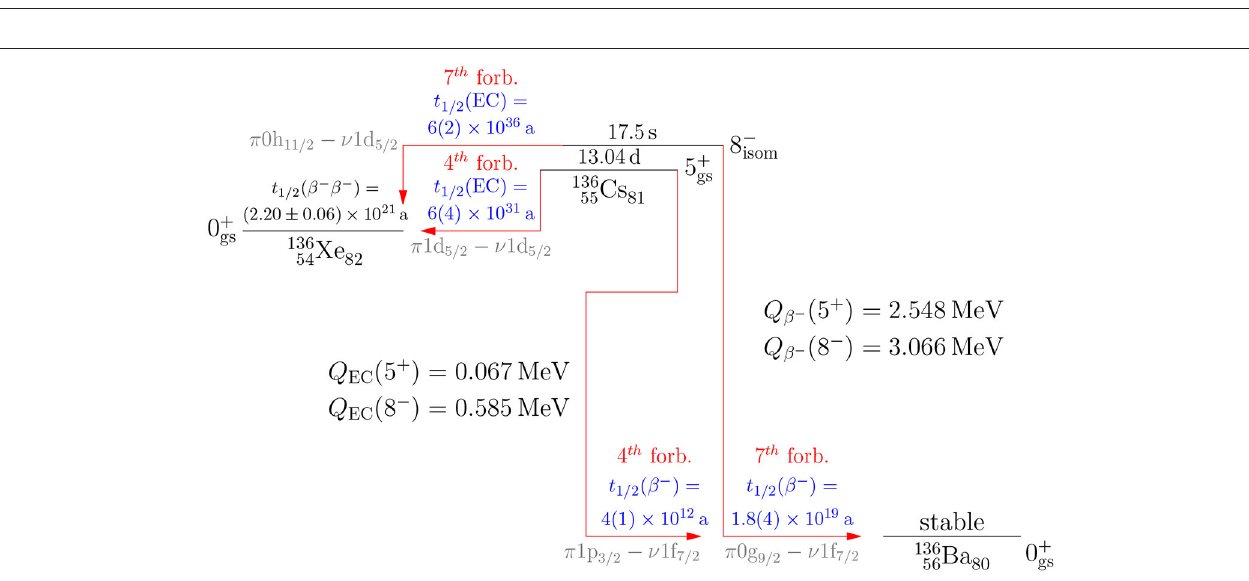
FIGURE 13 | Normalized ISM-computed electron spectra for the second-forbidden non-unique β − transition 98 Tc(6 + ) The branching to this decay channel is 100%. The value g V